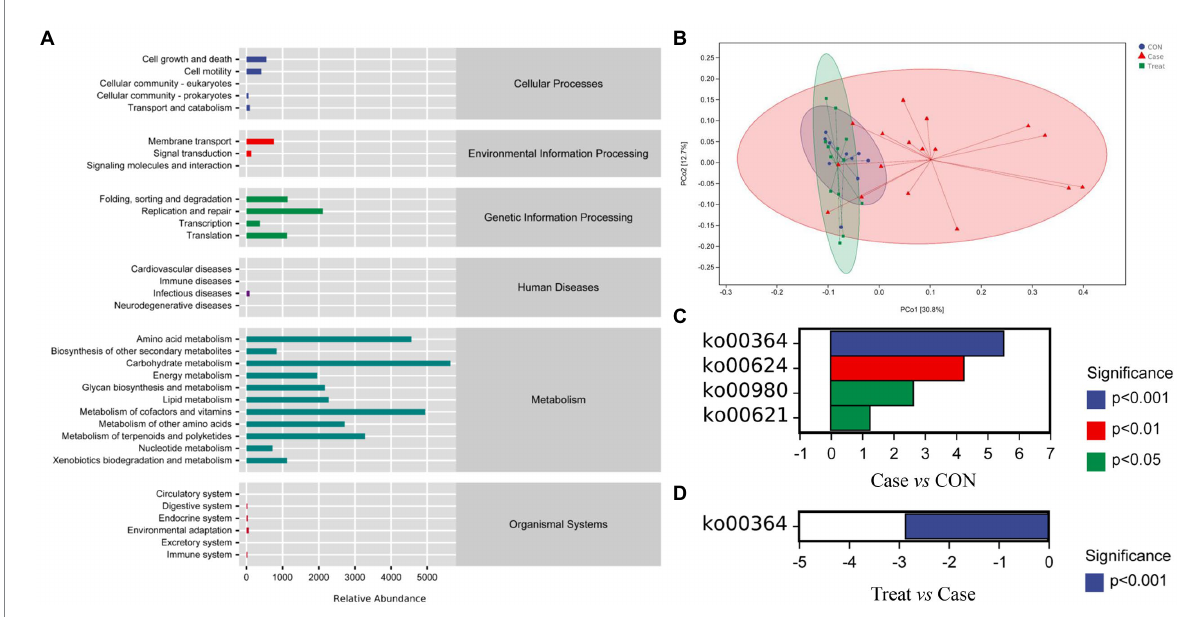
FIGURE 5 KEGG metabolic pathway. (A) KEGG metabolic pathway. (B) Functional unit PCoA analysis. Not: Each point in the functional unit PCoA analysis result diagram represents a sample, and points of different colors indicate different samples (groups). The percentage in the brackets of the coordinate axis represents the proportion of the sample difference data (distance matrix) that can be explained by the corresponding coordinate axis. The closer the projection distance of the two points on the coordinate axis, the more similar the functional composition of the two samples in the corresponding dimensions. (C) Metabolic pathway difference analysis between Case group and CON group. (D) Metabolic pathway difference analysis between Treatment group and Case